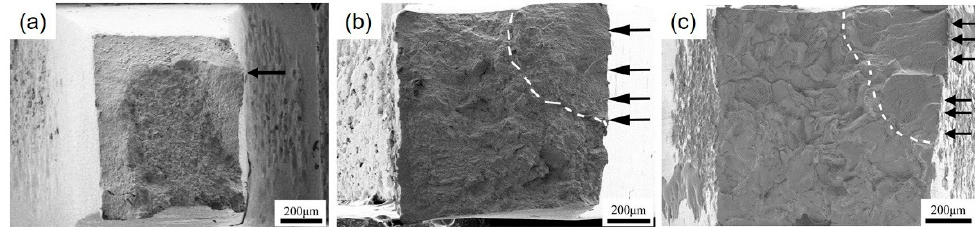
Figure 5. Morphology of ratcheting-fatigue fracture surface of harmonic-structured SUS316L steels: ( a ) MM0h compact; ( b ) MM10h compact; ( c ) MM30h compact.